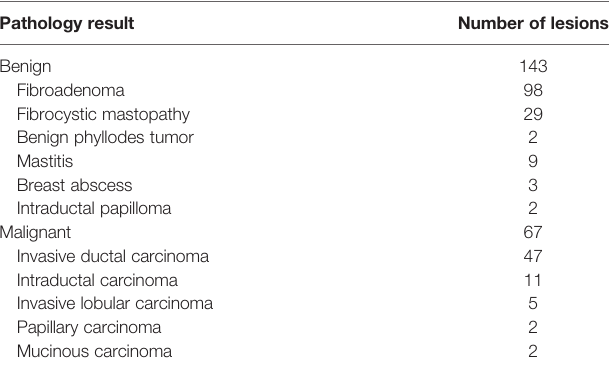
TABLE 1 | Pathology of 210 breast